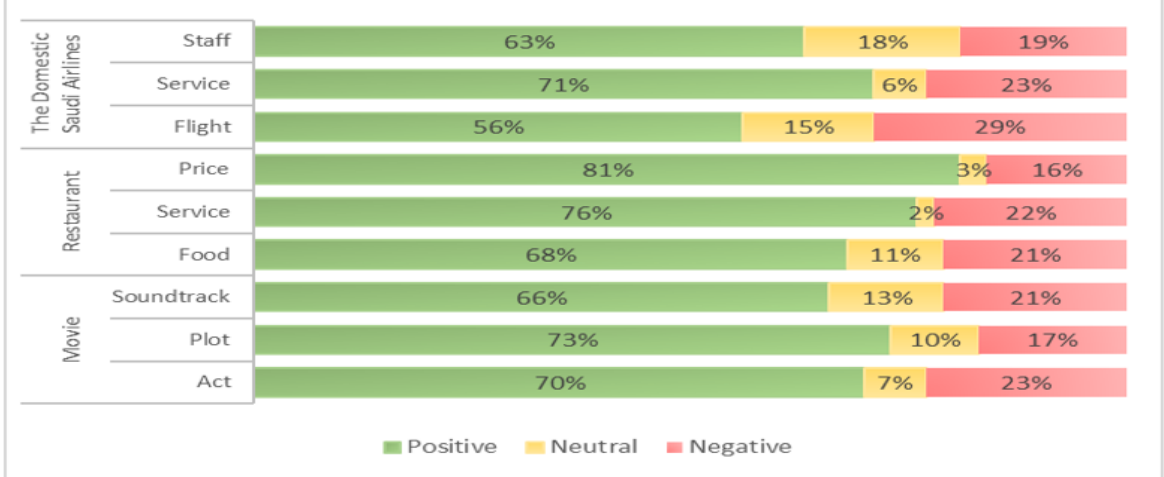
Table 6. Performance comparison of baseline classifiers on three various domains.